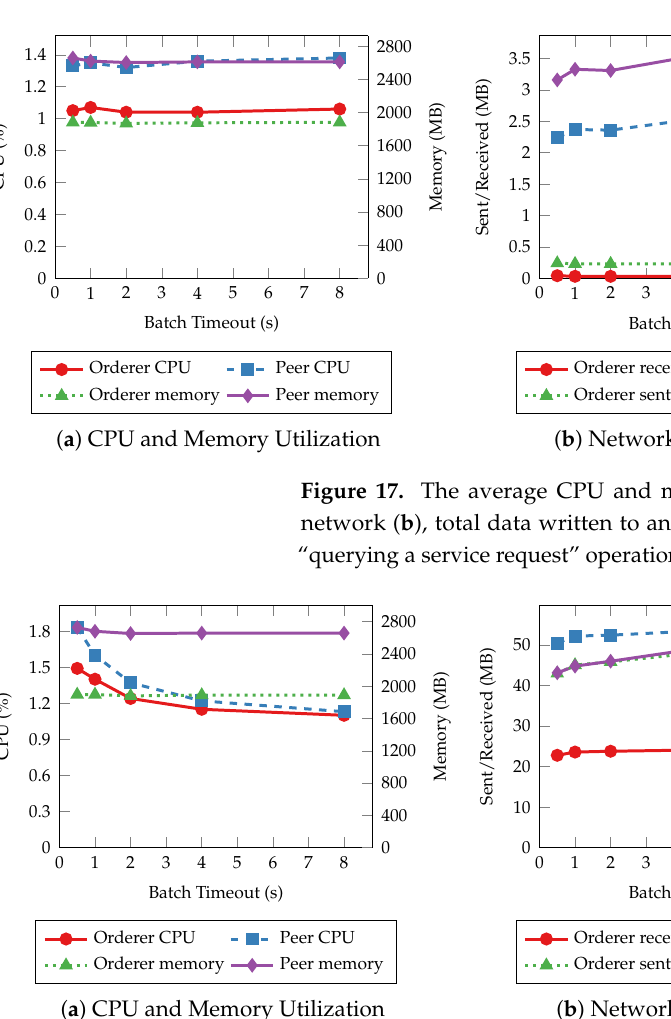
Figure 16. Throughput and latency of transaction operations for varying batch timeouts.